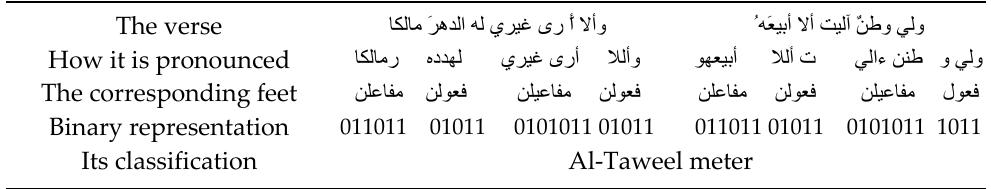
Table 17. An example of a verse of an Arabic poem and how it is classified into poetry meters (Adapted from [108] ).